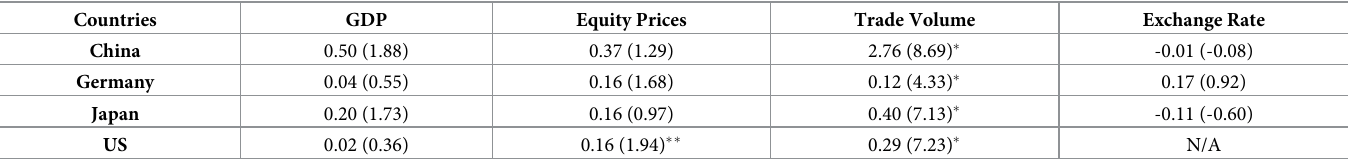
Table 13. Contemporaneous effect of foreign variables on domestic